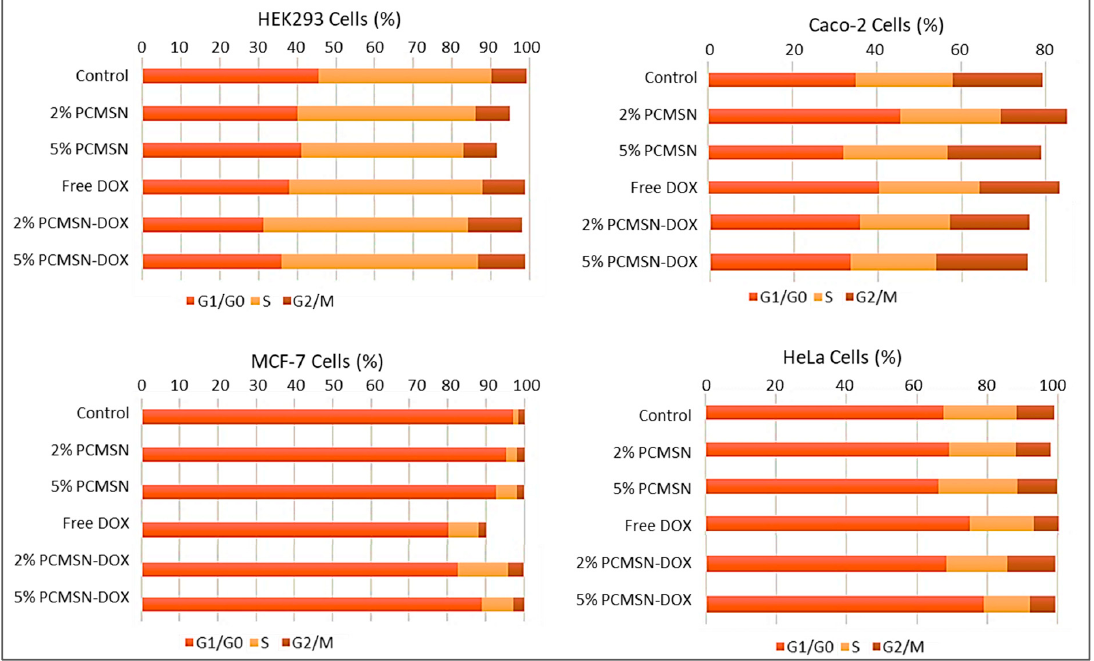
Figure 9. Cell cycle distribution in HEK293, Caco-2, MCF-7, and HeLa cells.